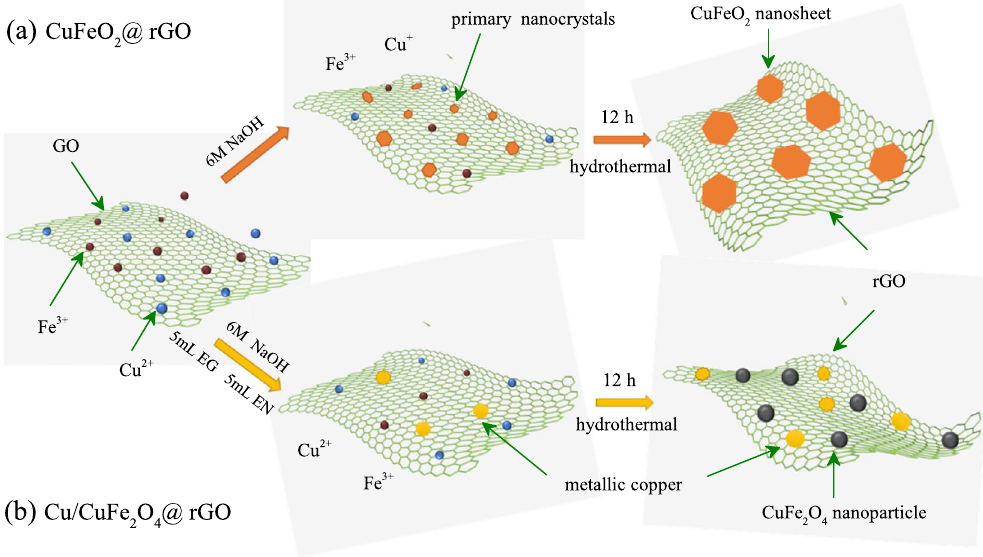
Figure 1. Schematic illustration of the synthesis of ( a ) CuFeO 2 @rGO and ( b ) Cu/CuFe 2 O 4